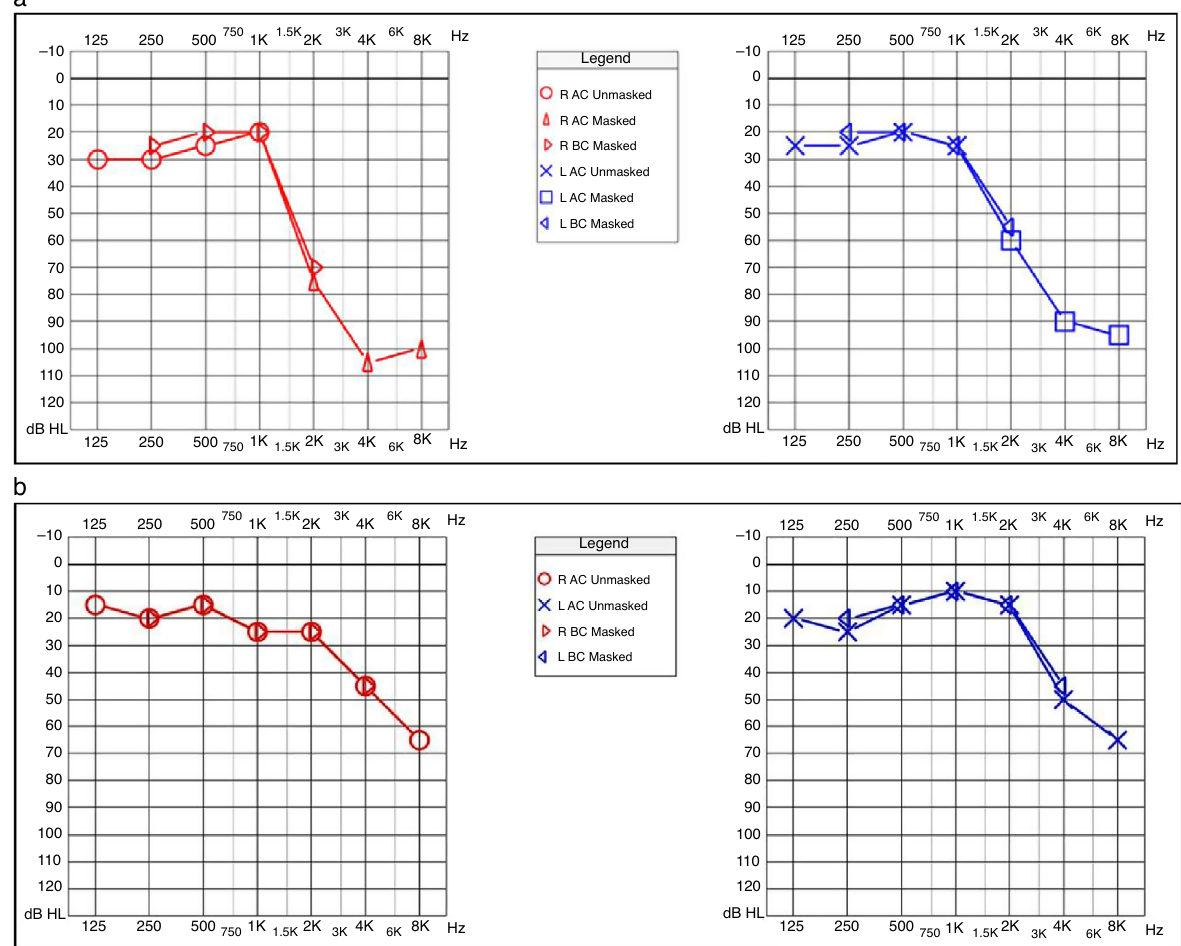
Pure-tone audiometric test showing moderate-severe bilateral sensorineural hearing loss for high frequencies with nearly symmetrical involvement, before (a) and after therapy